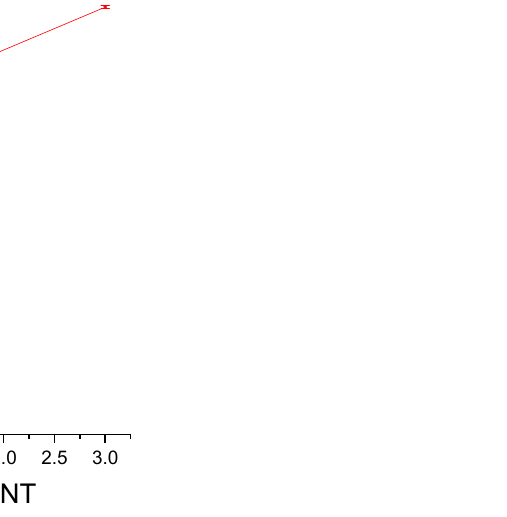
Figure 7. Dependence of specific conductivity of the chitosan/SWCNT composite films on the content of carbon nanotubes.